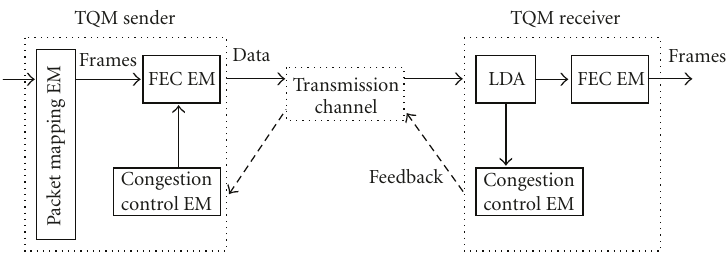
Figure 3: FEC-on-TQM transmission